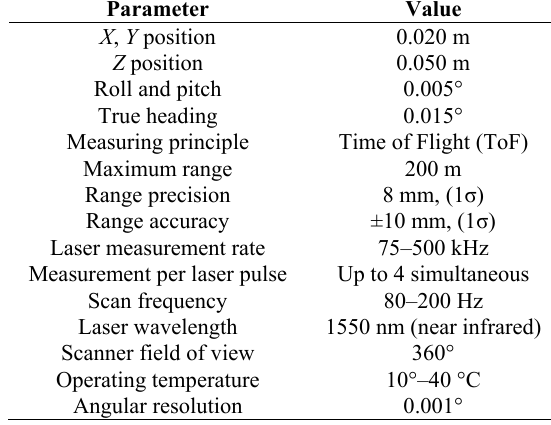
Table 1. Technical specifications of Optech LYNX Mobile